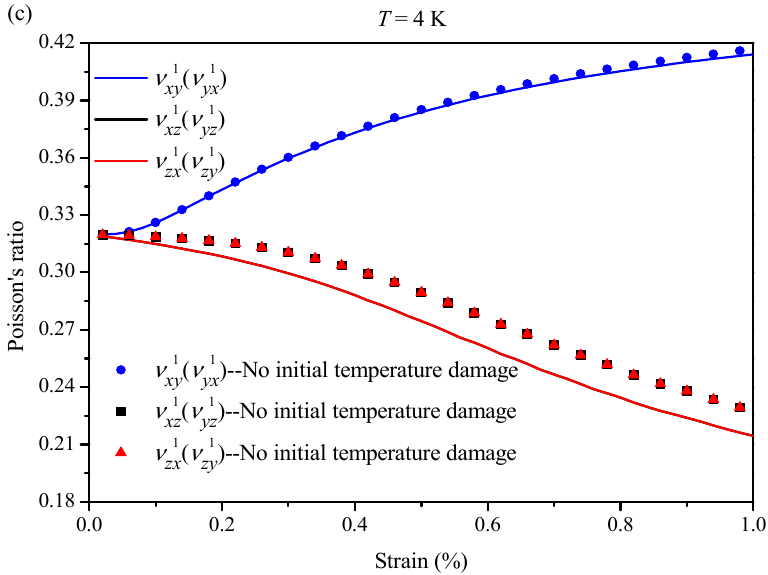
Figure 9. T = 4 K, EAS-Nb 3 Sn level 1 homogeneous fiber bundle considering damage in different directions: ( a ) Young’s modulus; ( b ) shear modulus; ( c ) Poisson’s ratio. (Note: The symbol “1” indicates the level 1 homogeneous fiber bundle.).